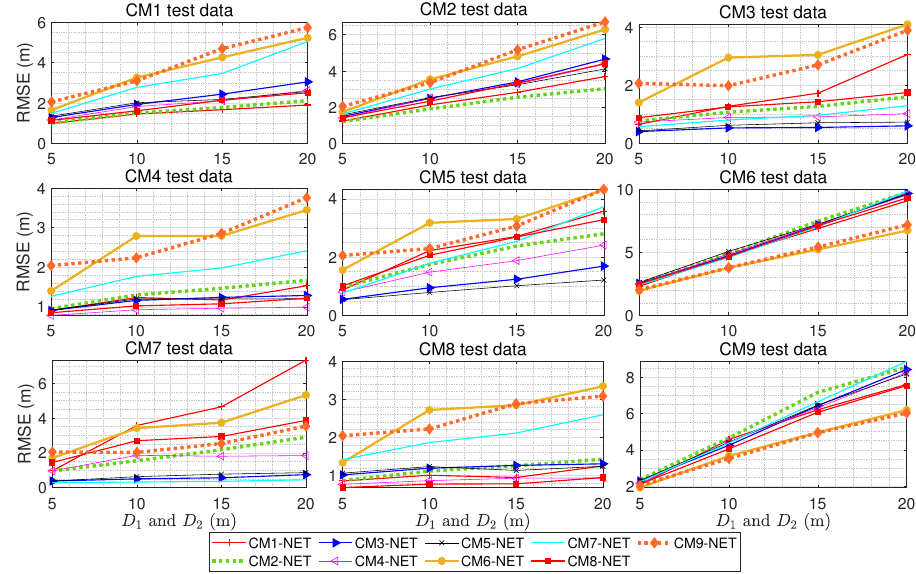
Figure 10. RMSE ( y -axis) across the area size ( x -axis, D 1 = D 2 ). CM#-NET is a CNN that is trained by using data generated under CM#. The CM#-NET is tested with various